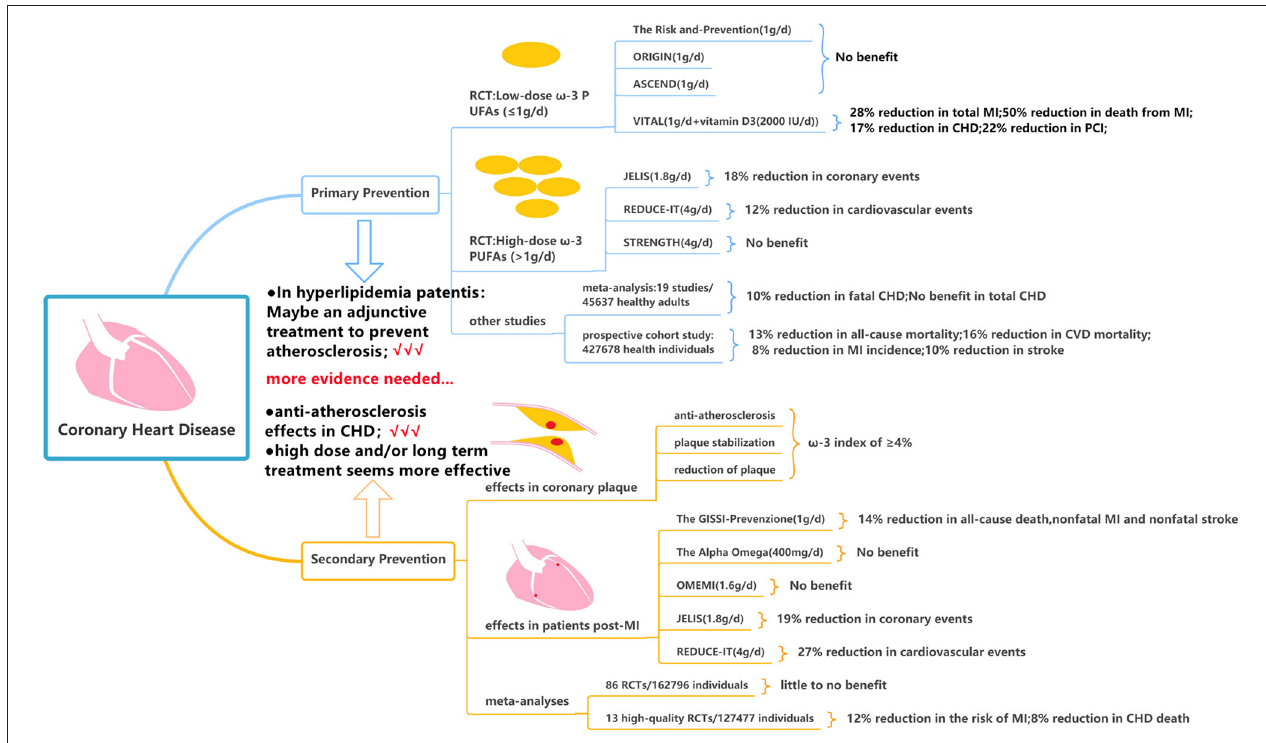
FIGURE 4 | Fish oil and the primary/secondary prevention of coronary heart